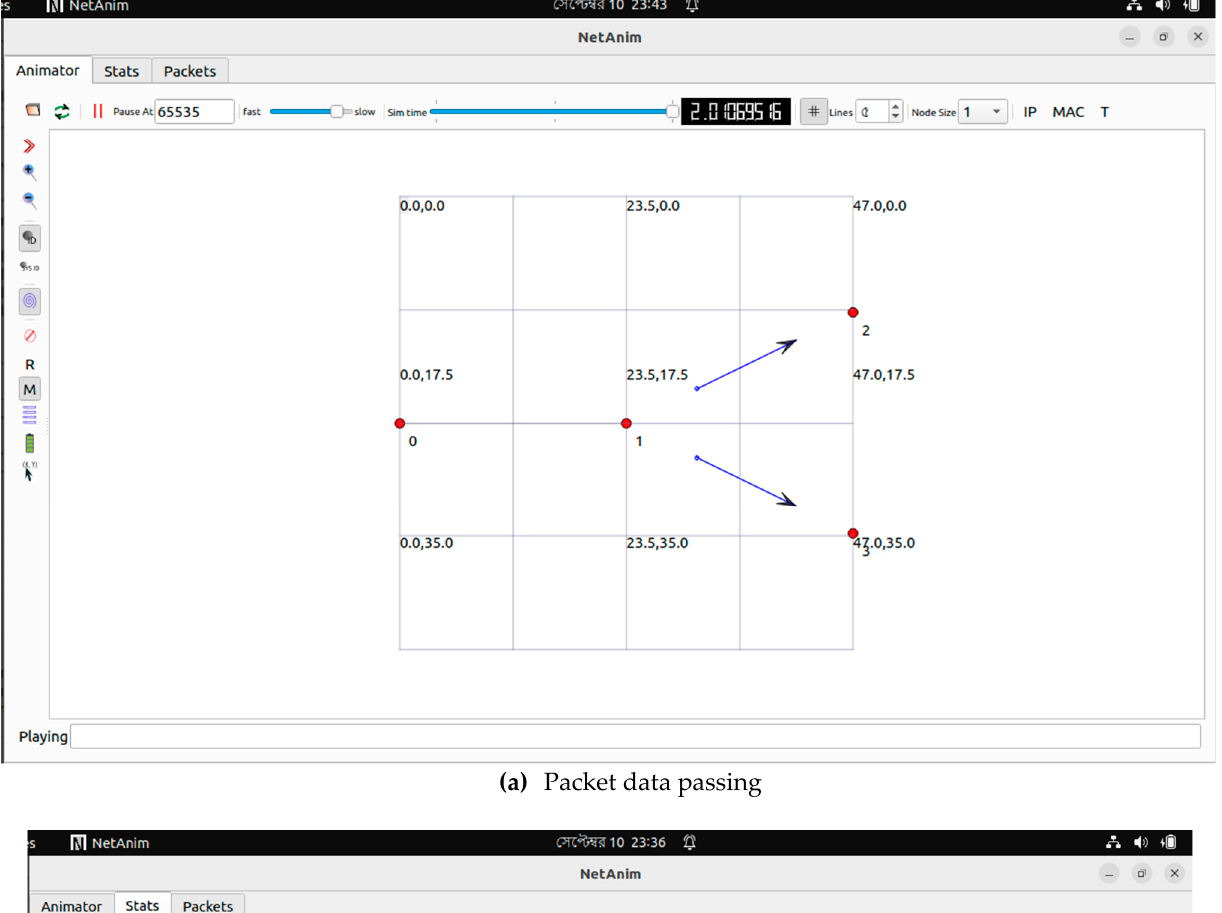
Figure 11. NS3 simulation from ULSM to HMS. (a)Packet data passing; (b)Node information.